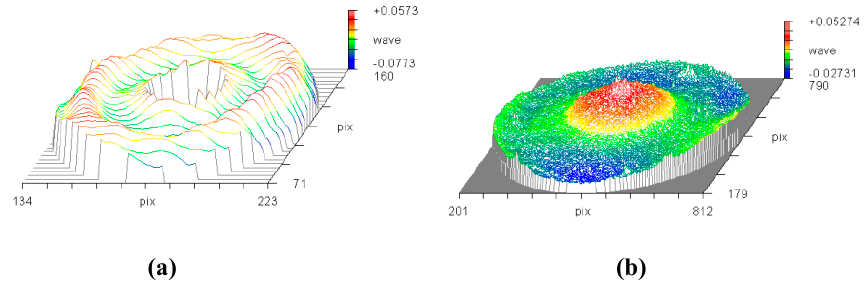
Figure 3. Surface measurement results for (a) primary mirror and (b) secondary mirror.